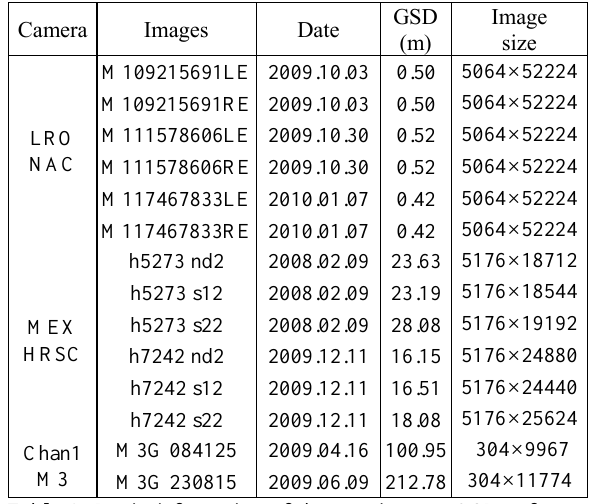
Table 2. Basic information of the test images. GSD refers to ground sample distance. Chan1 indicates